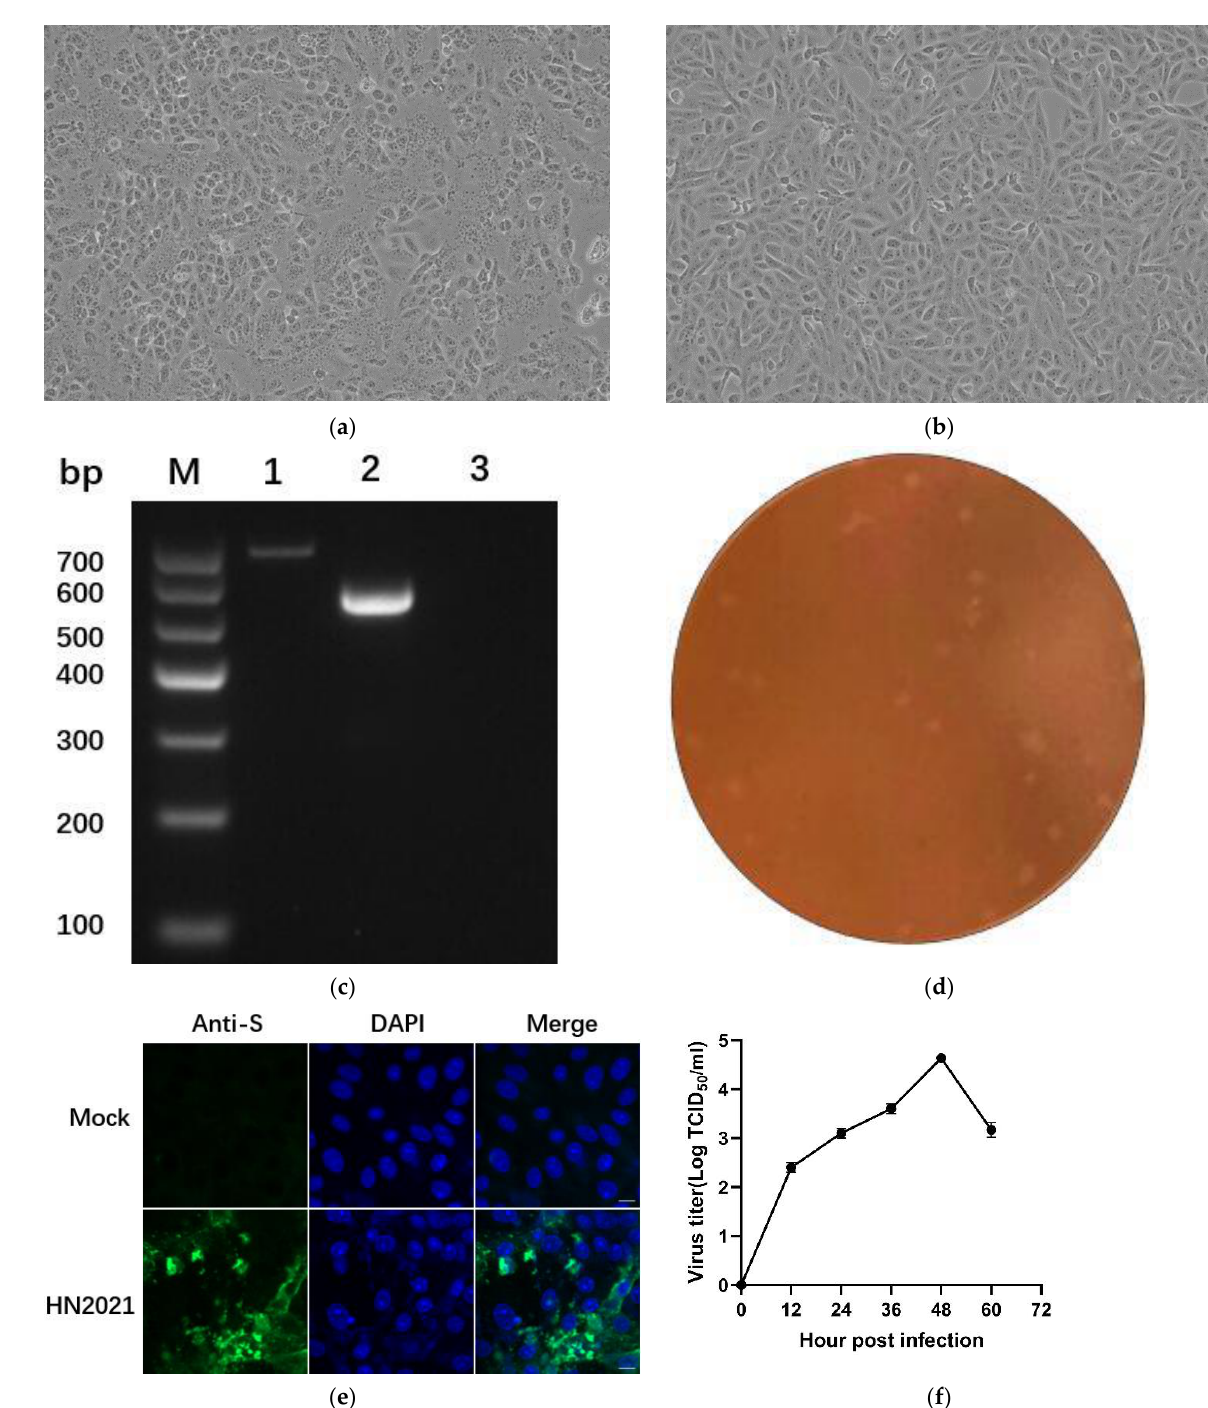
Figure 4. Virus isolation and purification of the HN2021 PEDV strains. CPE formation in Vero cells infected with ( a ) the HN2021 showing as rounded and clustered at 48 hpi (200×). ( b ) Vero cells control (200×). ( c ) Detection and amplification of the ORF3 gene in PEDV strains. M: DL Marker Ⅰ ; Lane 1: PEDV-HNCADC-2017 with intact ORF3 gene (~740 bp); Lane 2: HN2021 with a large genomic deletion (~508 bp); Lane 3: negative control. ( d ). Plaque purification of PEDV HN2021 strain. Monolayers of Vero cells were inoculated with PEDV HN2021 strain. After incubation for 2 h, the cells were overlaid with 1.5% agarose. Plaques were stained with neutral red dye at 48 hpi. ( e ) Detection of PEDV infection in Vero cells by IFA. ( f ) Growth curves of PEDV HN2021 isolate at passage 10 in Vero cells. Data is presented as mean ± SD by triplicates.